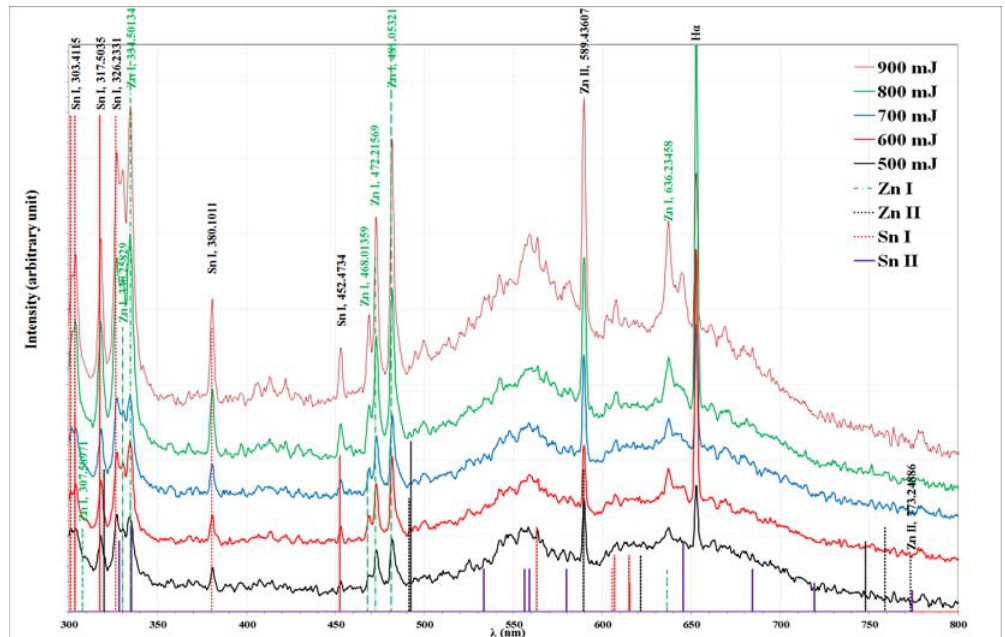
Fig.2 (c): Spectroscopic patterns for plasma emission from X= 0.6 SnO different laser